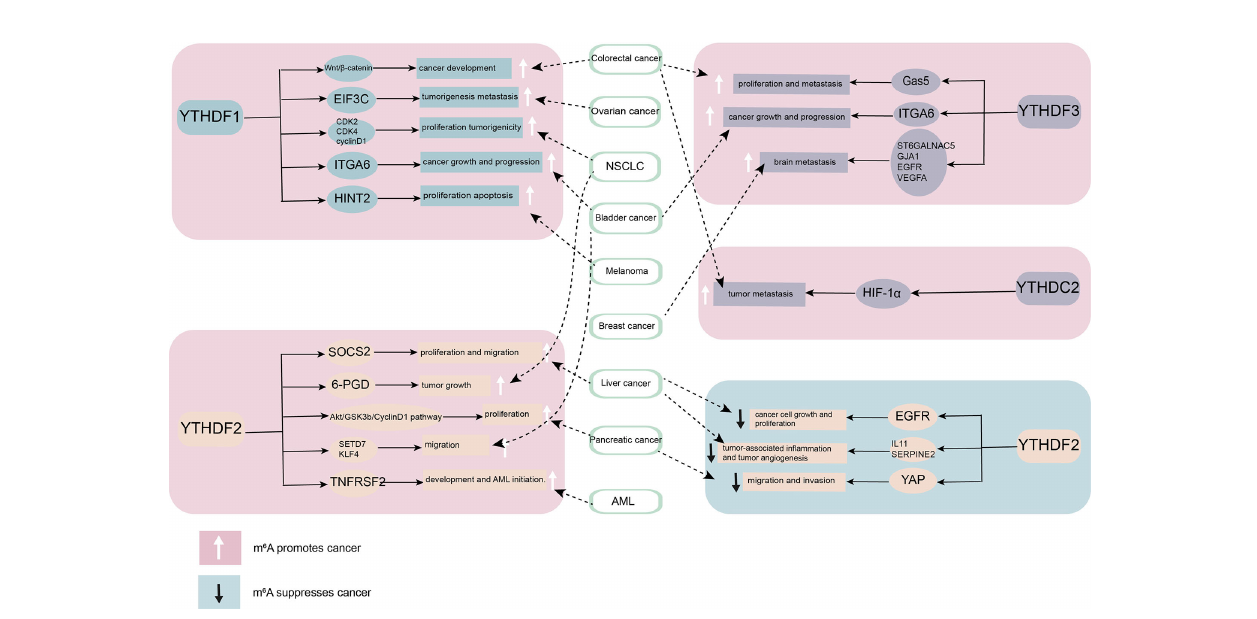
FIGURE 2 | The role of YT521-B homology (YTH) domain family proteins in cancer. By combining different downstream targets, YTH domain family proteins promote or inhibit the occurrence and development of cancer. YTHDF1, YTHDF3, and YTHDC2 mainly play a role as cancer promoting factor. YTHDF2 plays diverse roles in different